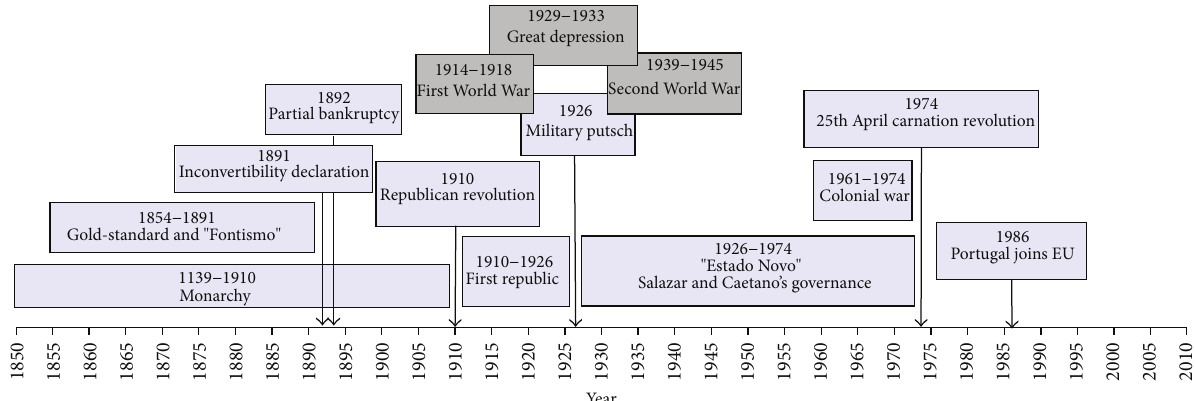
Figure 1: Timeline of Portuguese history over the last 150